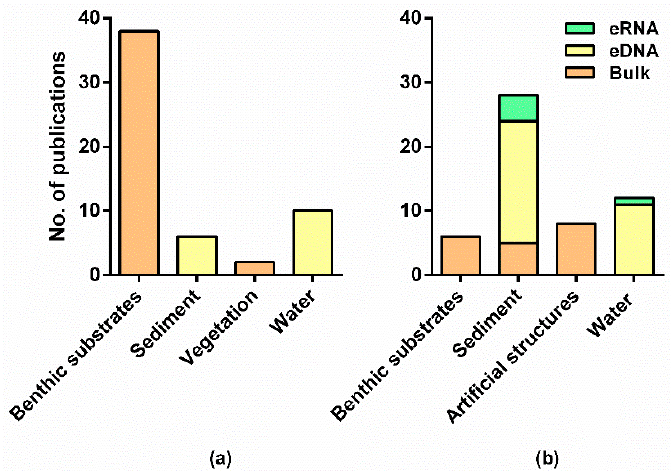
Figure 3. Sampled substrates and targets type (environmental RNA (eRNA), environmental DNA (eDNA), or bulk community) for assessing macroinvertebrate diversity through metabarcoding in ( a ) fresh and ( b ) transitional/marine waters.